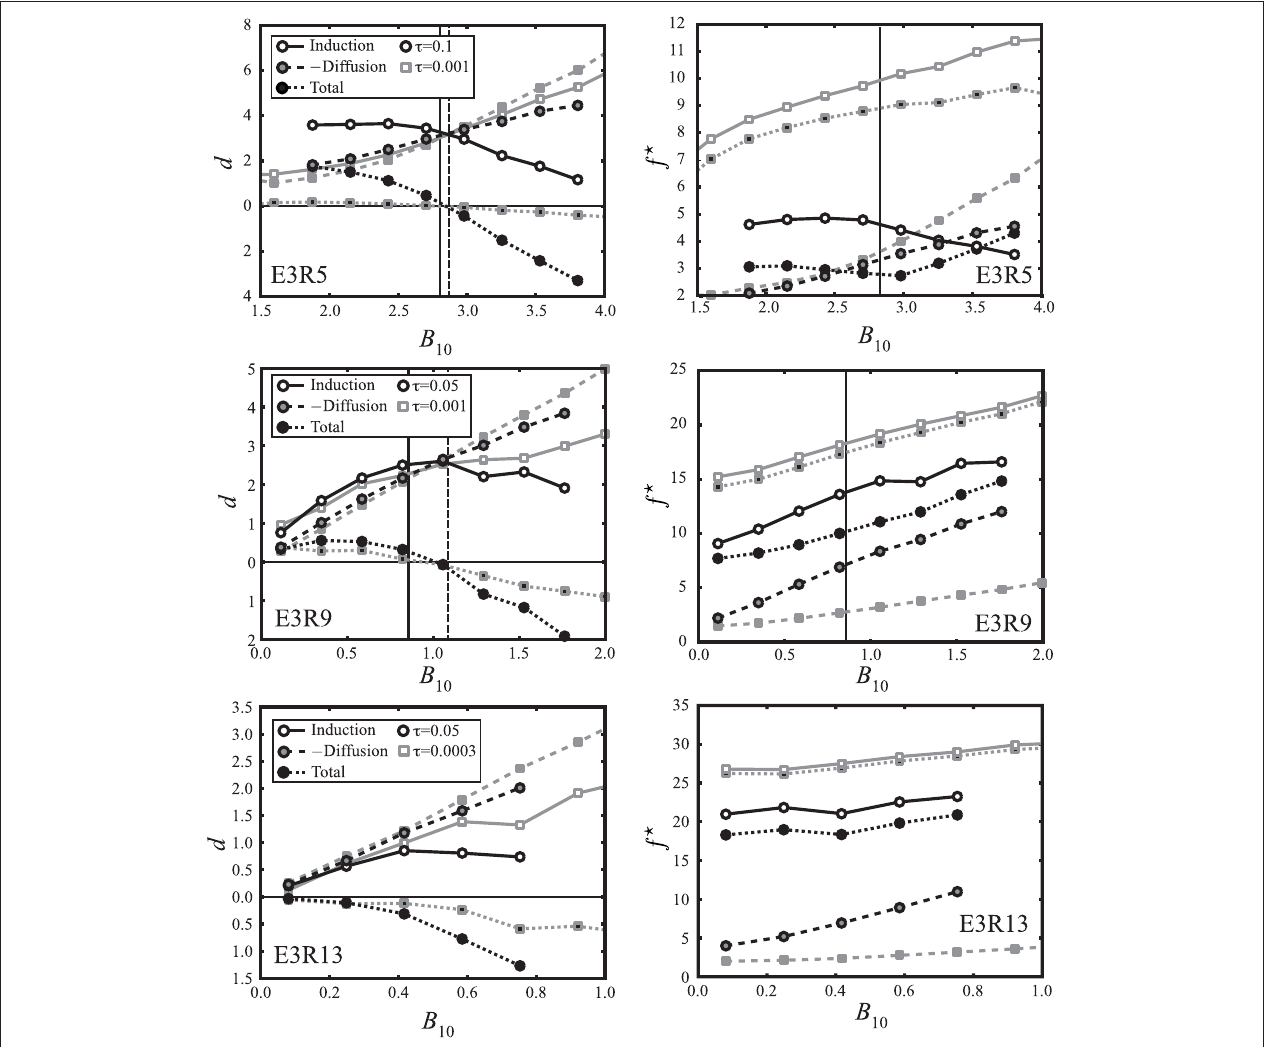
FIGURE 11 | Axial dipole variations beneath the outer Ekman boundary layer in models E3R5 (top panels), E3R9 (middle panels) and E3R13 (bottom panels). The left panels show separate drift profiles for induction d ( I ) (solid lines with open symbols), negative diffusion − d ( D ) (dashed lines with gray filled symbols) and the total d (dotted lines with black filled symbols). Two different time resolutions τ have been used, the smallest available for the respective numerical data set (squares), and a value τ > τ c when the Langevin and Fokker-Planck formalisms can be expected to hold (circles). The right column shows the respective rescaled fluctuation profiles f ⋆ . For E3R9 (E3R13) the black profiles have been amplified by a factor 3 ( 5 ). The solid (dashed) vertical line marks the axial dipole mean (mode). All values are given in dimensionless units.